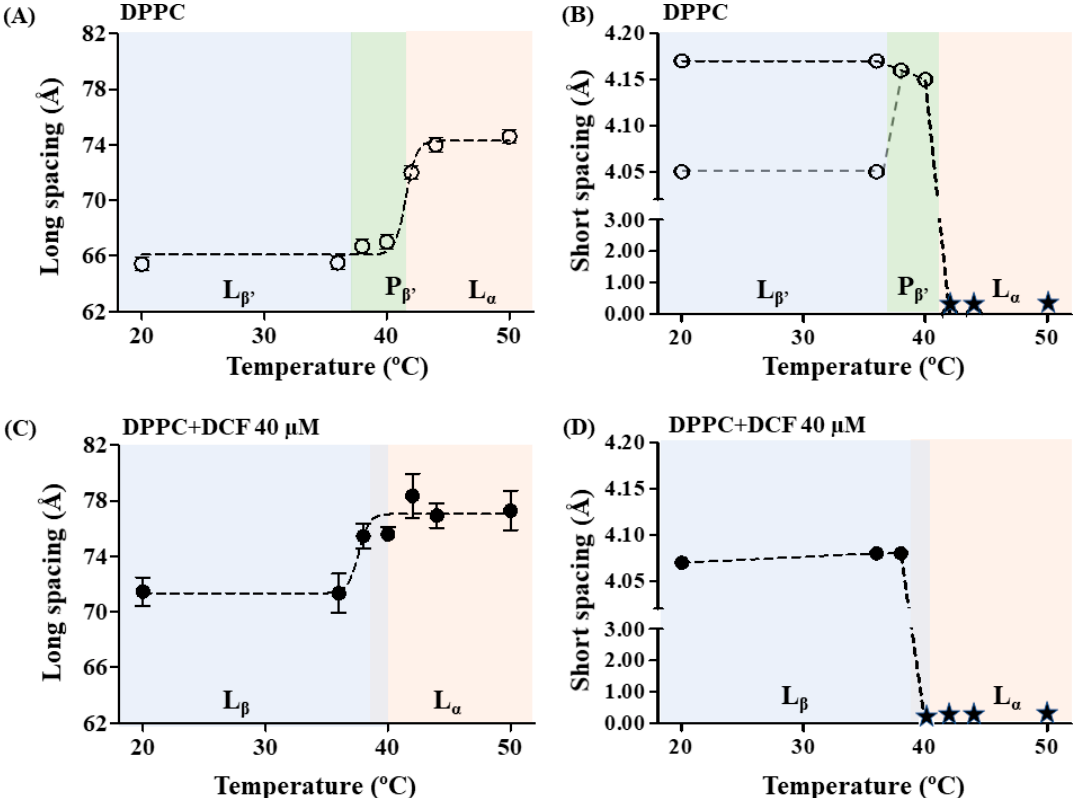
Figure 6. Long and short spacing obtained, respectively, by SAXS ( A , C ) and WAXS ( B , D ) measurements of DPPC multilayers made at several temperatures and at pH 5.0 in the absence (open symbols) and in the presence (closed symbols) of DCF. Values are presented as average spacing ± standard deviation calculated from all diffraction peaks. Dashed lines are guidelines only, and star symbols are temperatures at which no Bragg peaks appear in the WAXS region. L β , L β ’ , P β ’ , and L α stand for lamellar gel phase ( β stands for untilted and β ’ stands for tilted), ripple phase, and lamellar fluid phase, respectively.